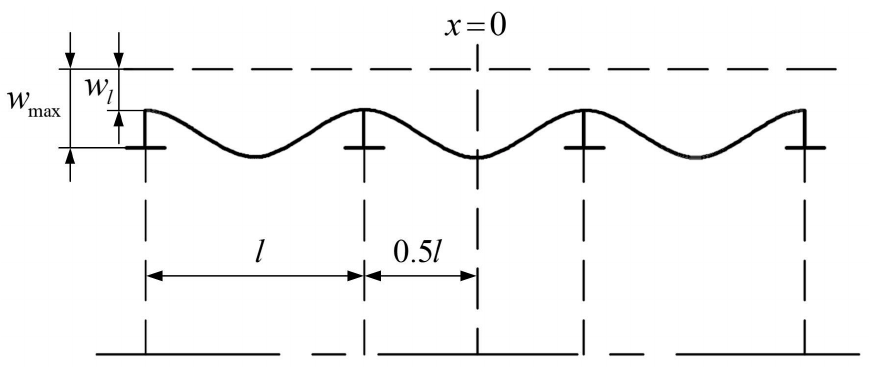
Figure 5. The bending deformation of the pressure hull in the direction of mainline.